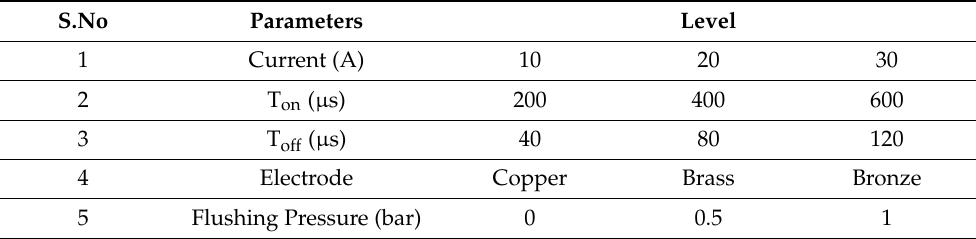
Table 4. Experimental